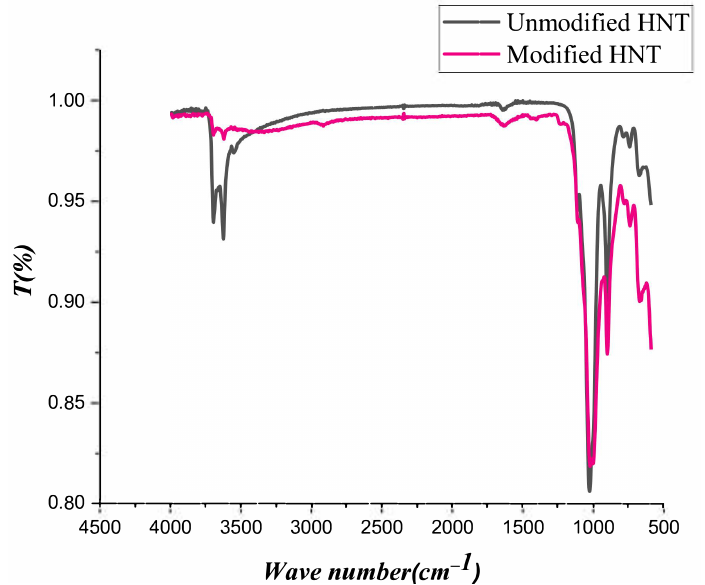
Figure 2. FT-IR spectra of unmodified HNT and modified HNT